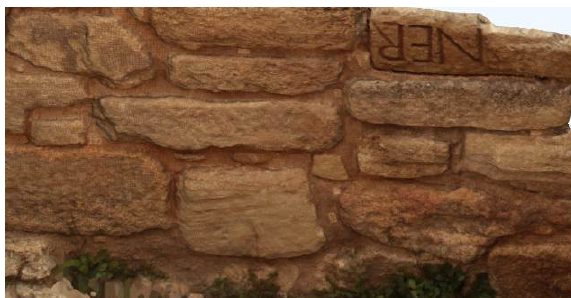
Figure 8. Multi-resolution model of “El Reguerón” area (up) and detail for the wall (down).